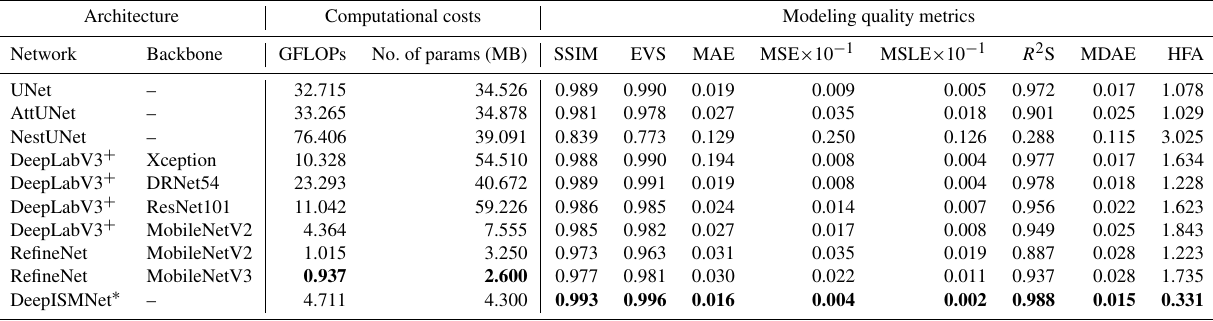
Table 1. A quantitative comparison between our network and the widely used powerful networks using various quality metrics. For each of the quality metrics, the best performance is highlighted in bold. The proposed network (DeepISMNet) is marked with an asterisk to distinguish it from the others. Note: GFLOPs is the giga floating point operations per second.